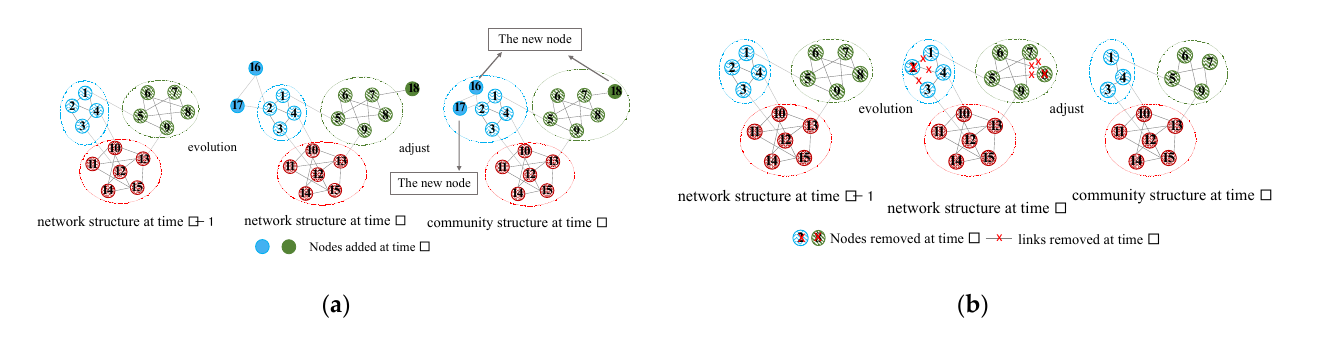
Figure 4. Schematic diagram of dynamic network evolution when |𝐶| does not change. ( a ) |𝐶| increases after adding nodes; ( b ) |𝐶| decreases after adding nodes.